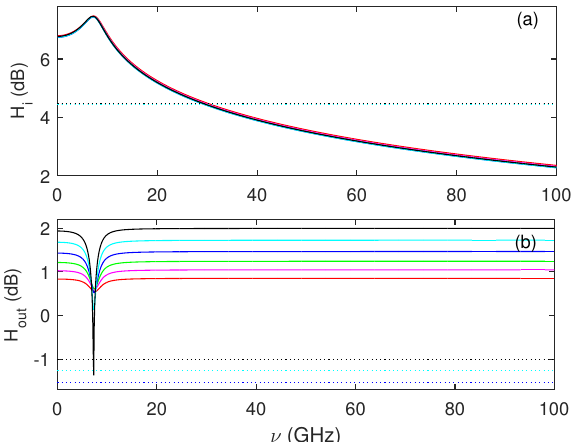
Figure 6. (color online) Same as Figure 4 but for the case of weak coupling between EAM and VCSEL cavities ( d EAM = 0.502 µ m). ( a ) and ( b ) correspond to modulation of injection current, i.e., H i ( ν ) from Equation (21) and EAM losses α EAM , i.e., H out ( ν ) from Equation (18),